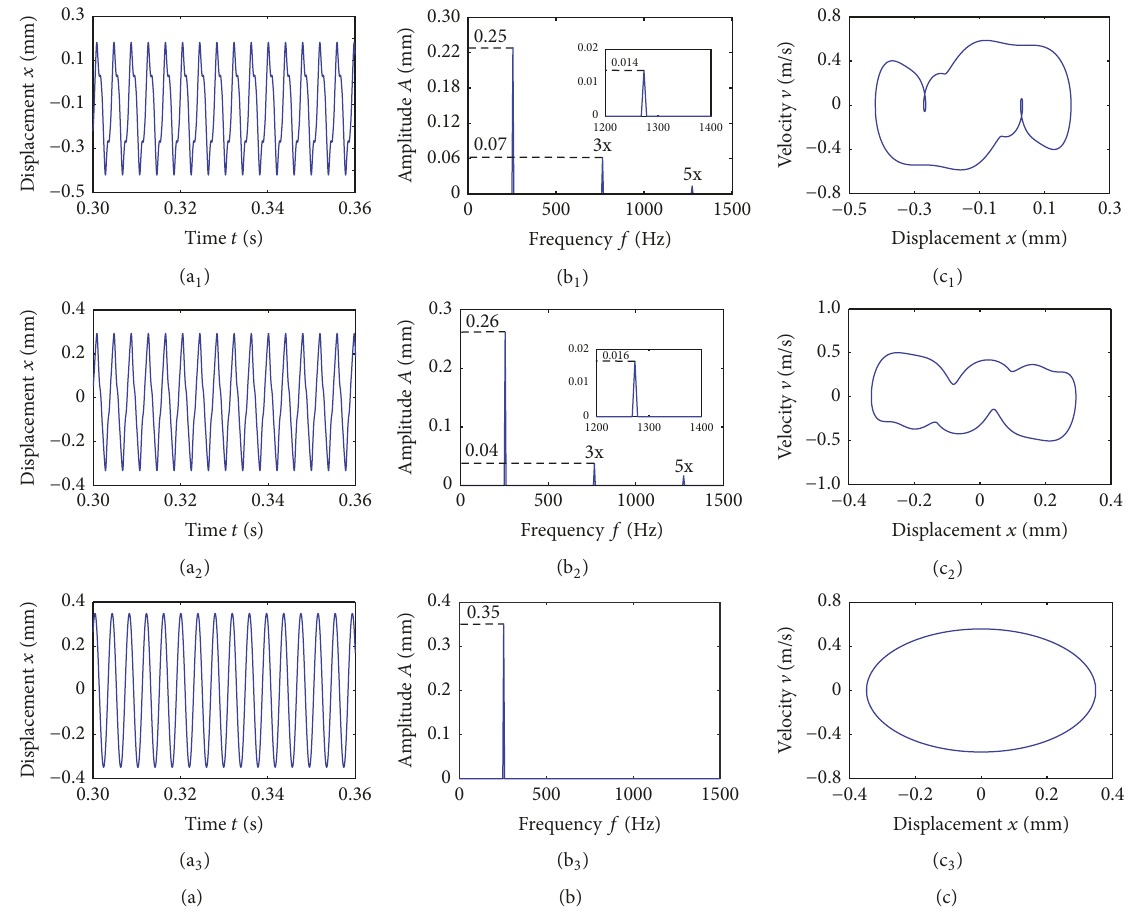
Figure 7: The responses of blade-root at different friction coefficients ((a) is the time-domain response, (b) is the frequency spectrum, and (c) is the phase